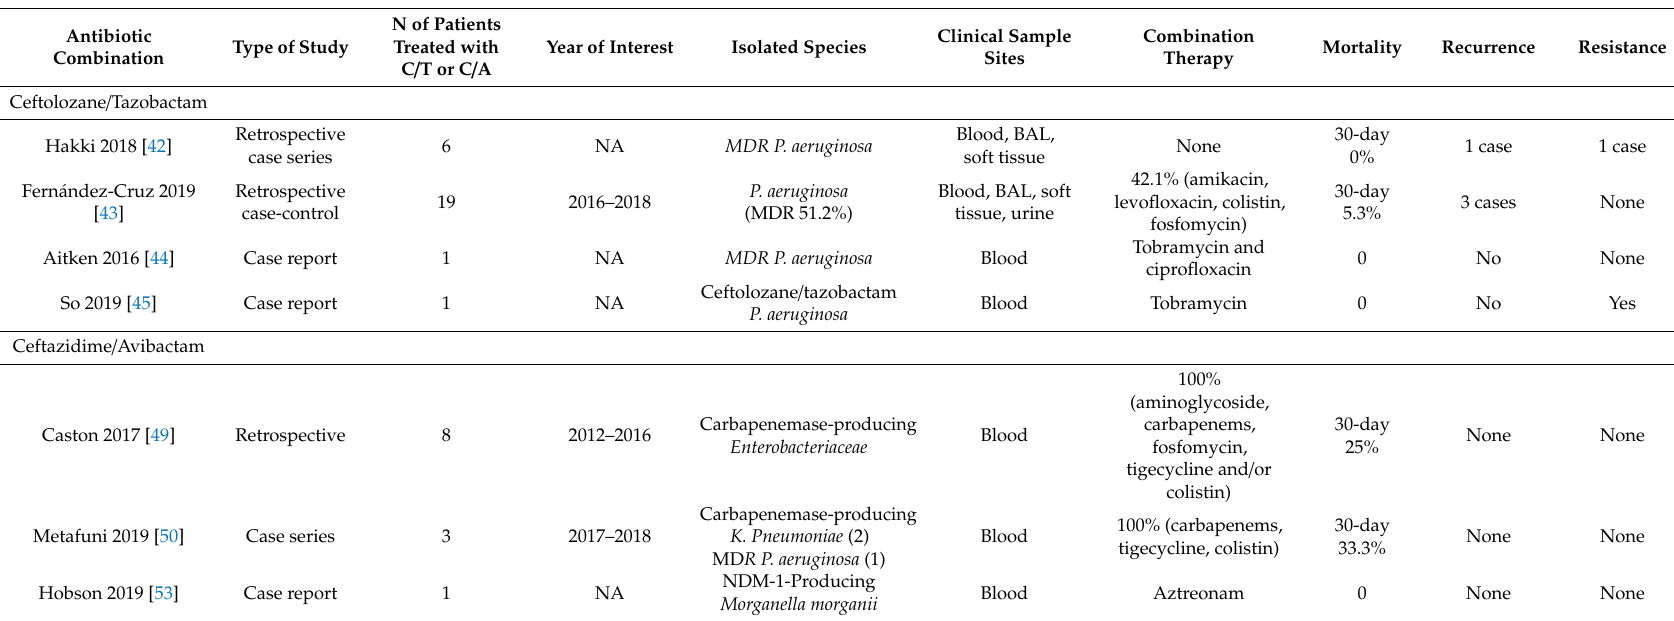
Table 2. “Real-life” experiences reported in published studies on use of ceftolozane / tazobactam and ceftazidime / avibactam for treatment of severe infections caused by MDR Gram-negative bacteria in patients with hematological